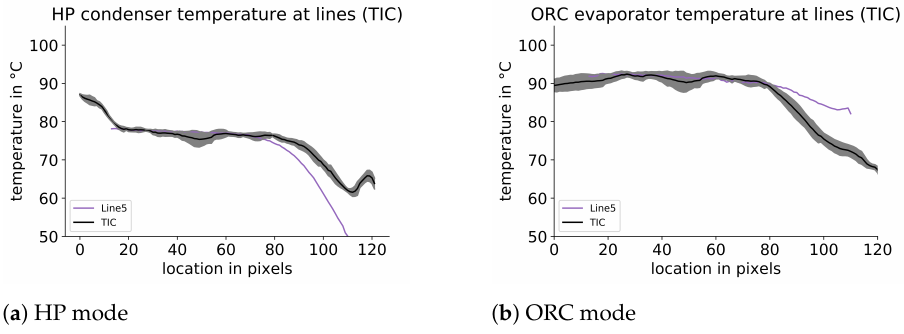
Figure 8. Temperature profiles of measure lines from the TIC image analysis (total